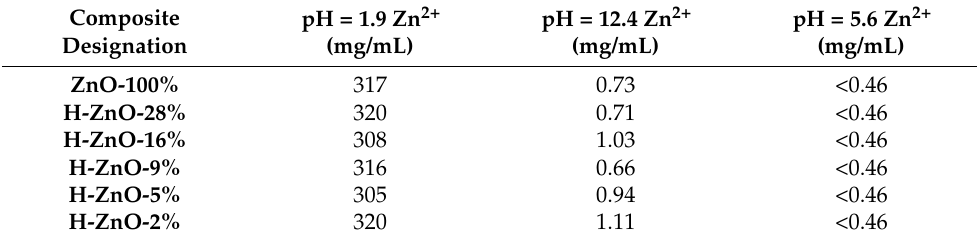
Table 3. Mobility of Zn 2+ ions determined by